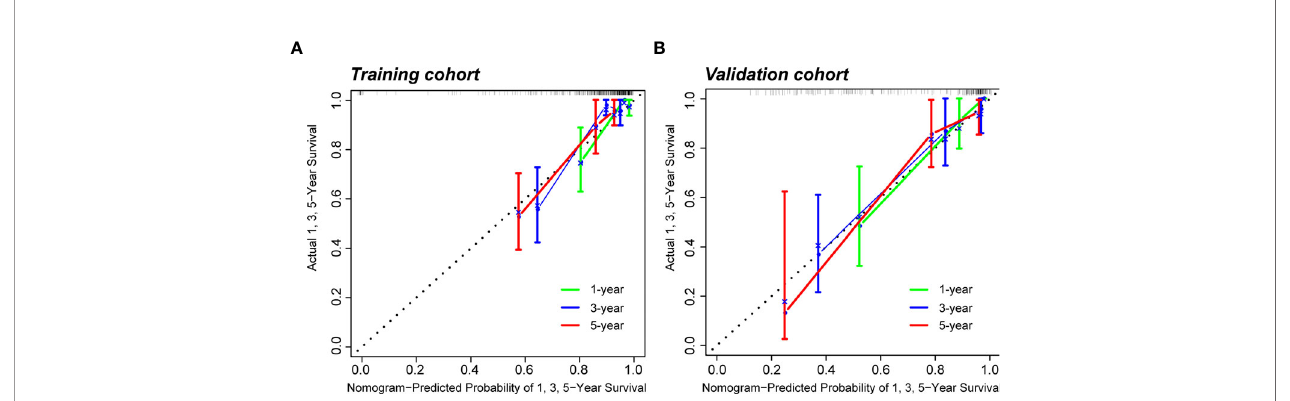
FIGURE 7 | Calibration curves of the predictive nomogram. (A, B) Calibration curves of the nomogram to predict the probability of PFI at 1, 3, and 5 years in the training cohort and the validation cohort. PFI, progression-free interval .